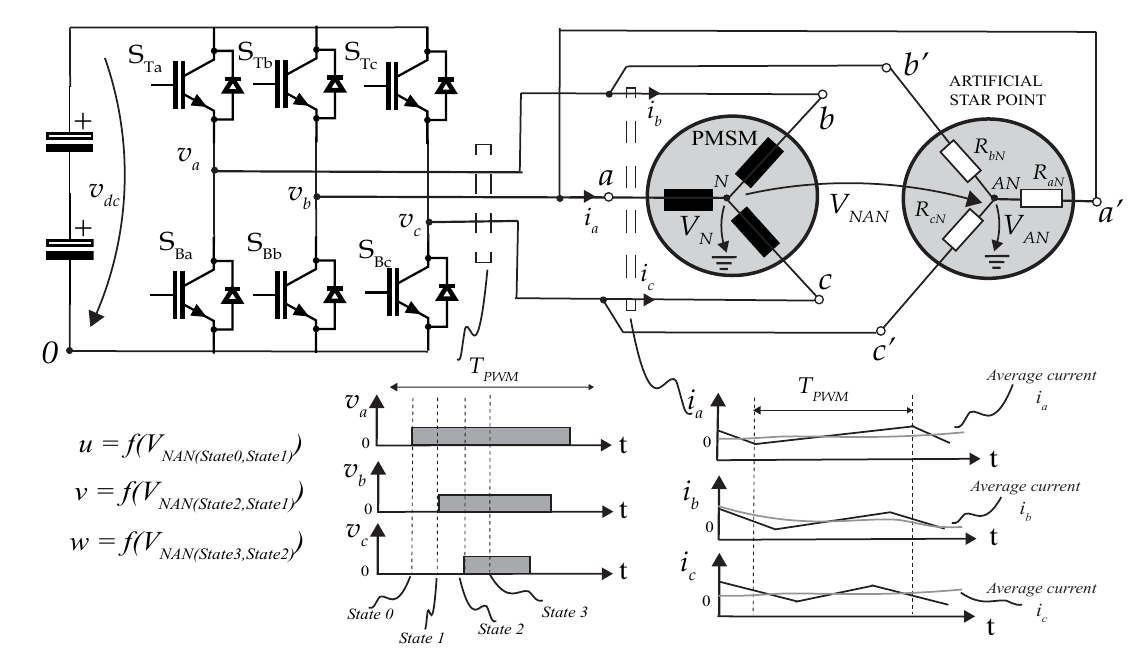
Figure 1. DFC Flux linkage signals’ measurement scheme.